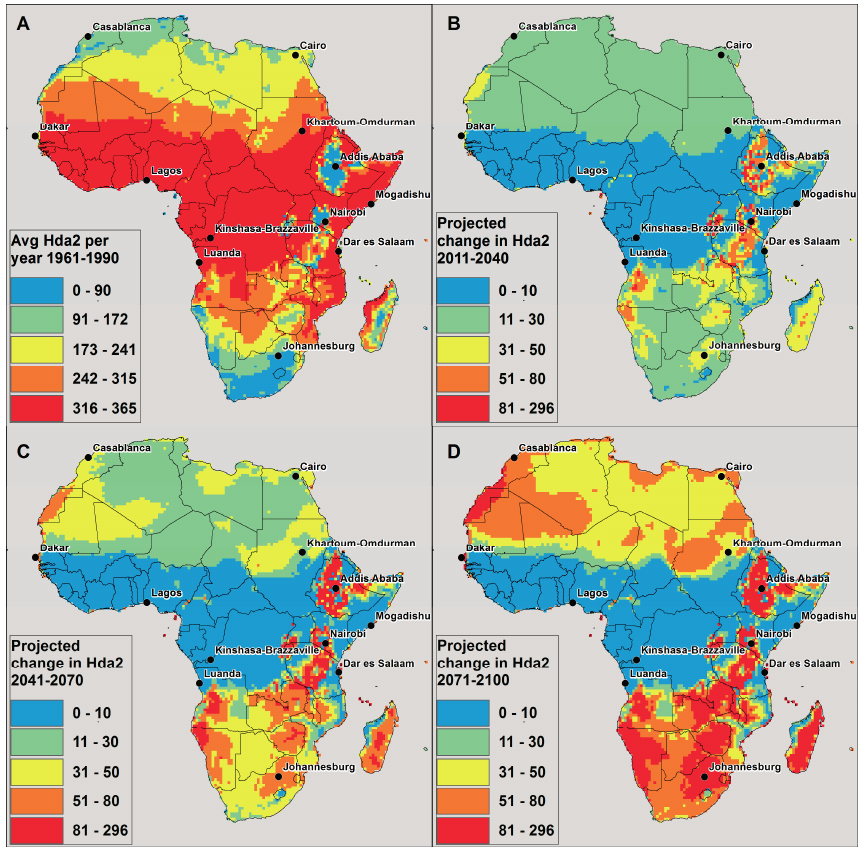
Figure 1. CCAM model derived ( A ) average number of Hda2 per year in present climate; ( B ) projected change in average number of Hda2 per year in 2011–2040 compared to 1961–1990; ( C ) projected change in average number of Hda2 per year in 2041–2070 compared to 1961–1990; ( D ) projected change in average number of Hda2 per year in 2071–2100 compared to